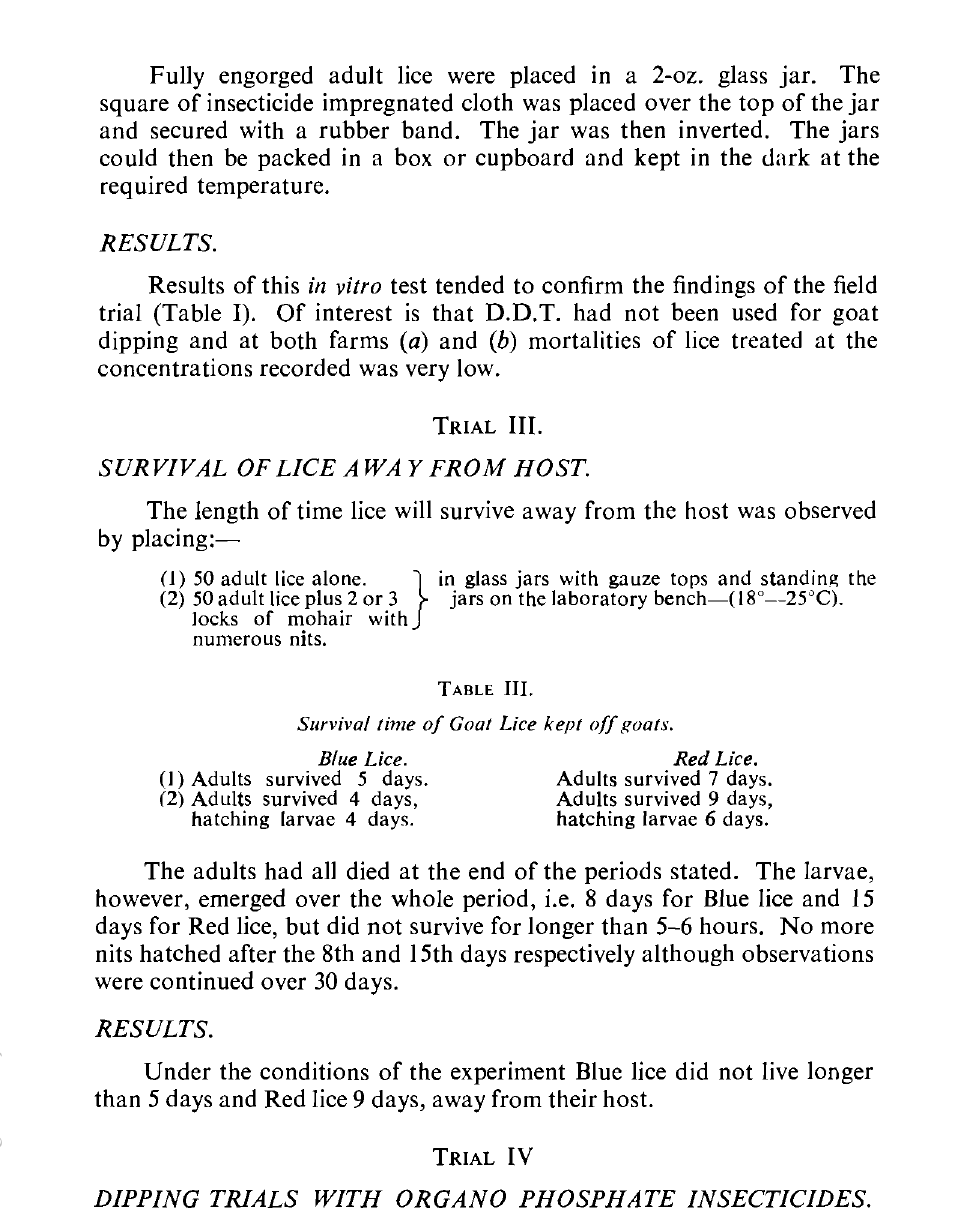
SlIrvival time of Goat Lice kept off